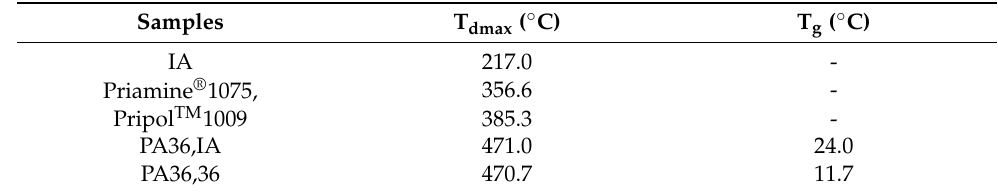
Table 2. Thermal degradation and glass transition temperatures of bio-based PA elastomers.